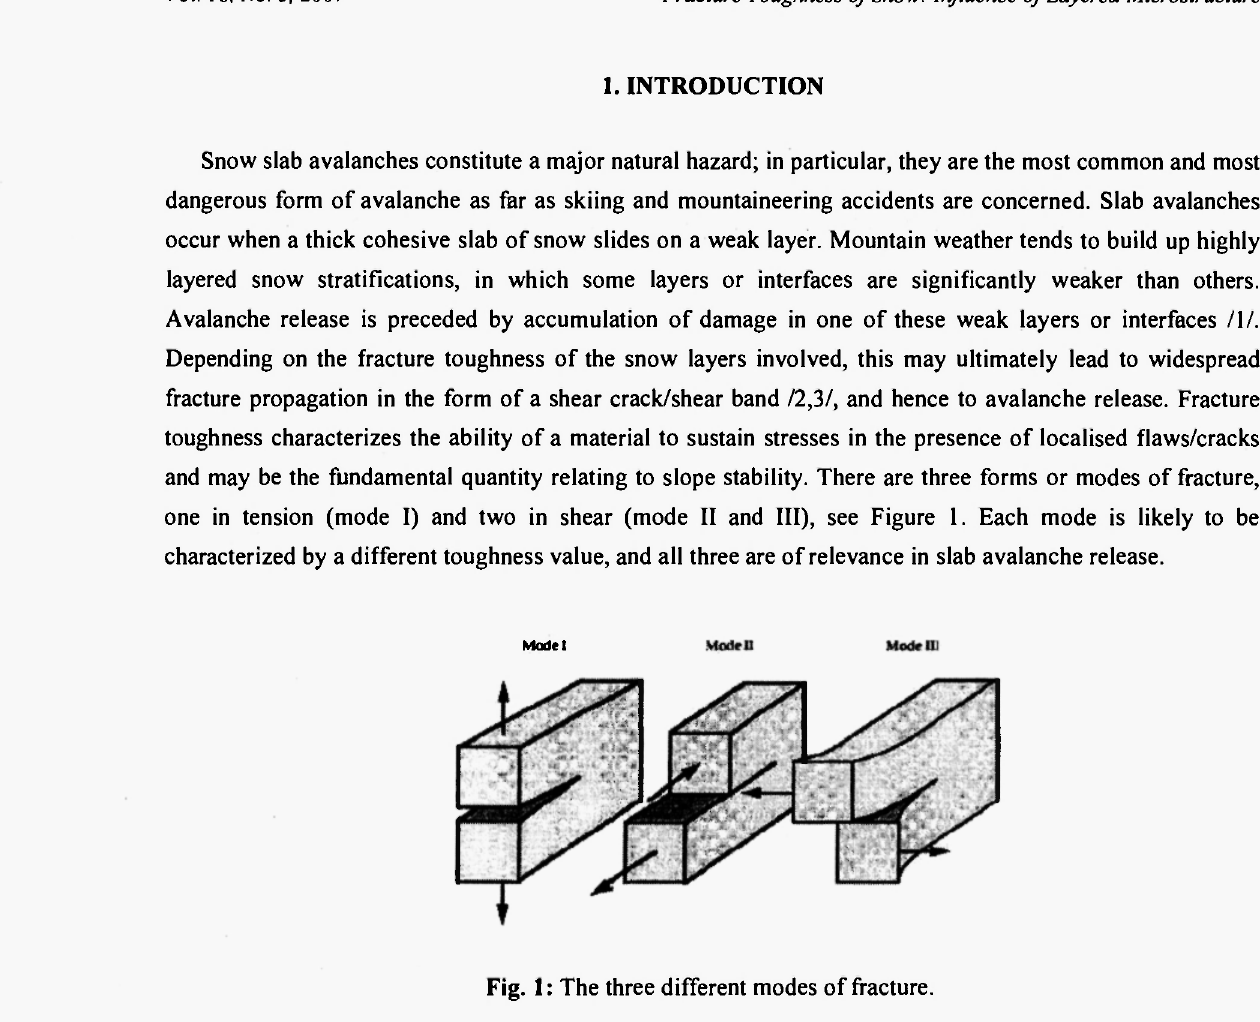
Fig. 1: The three different modes of